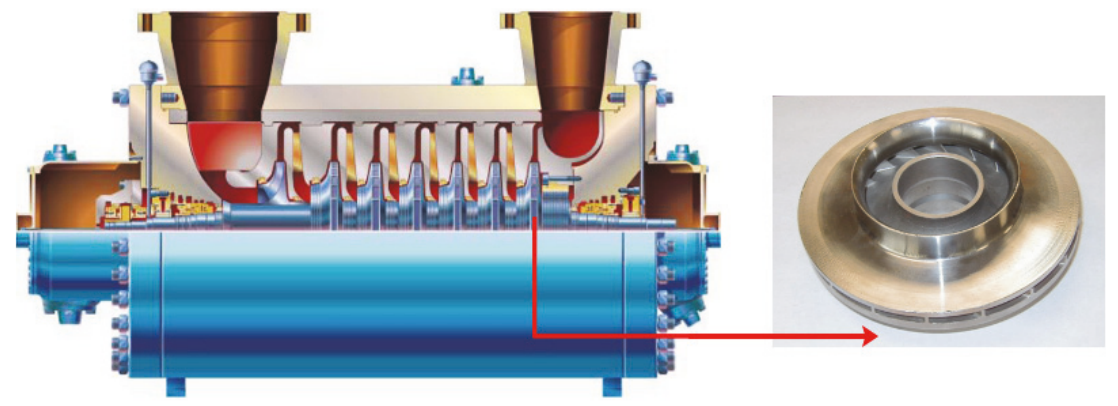
Figure 4: GE impeller used as a starting point for carrying out the novel design.